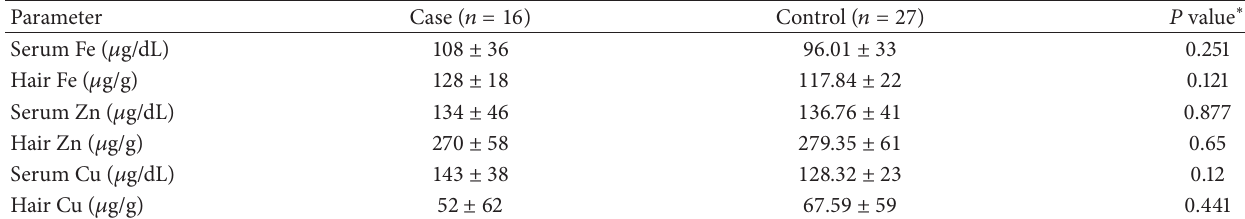
Table 2: Serum and hair level of trace elements in patients and